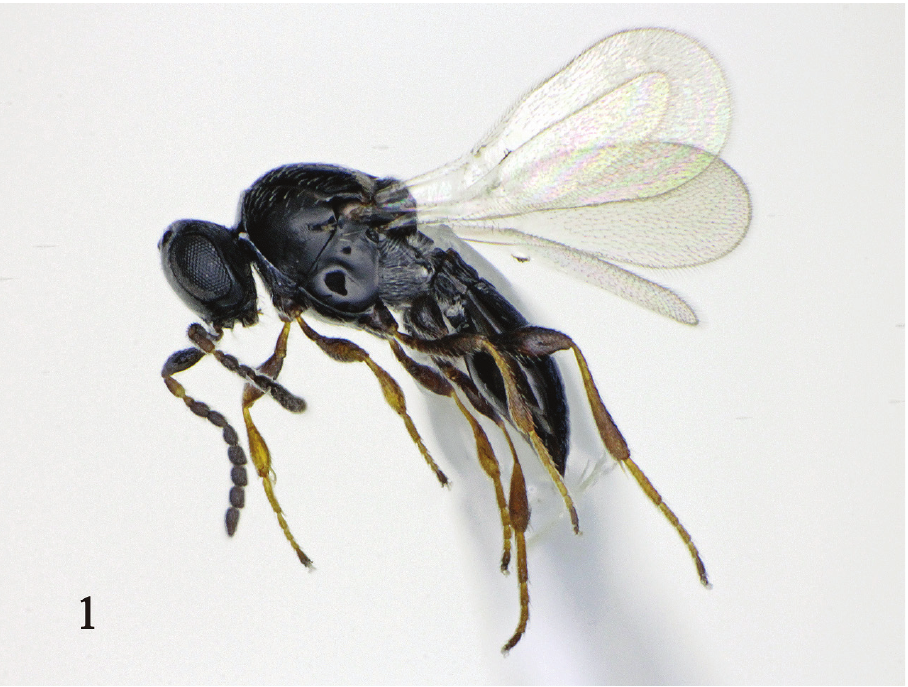
Figure 1. Holotype female of Platygaster ingeniosus